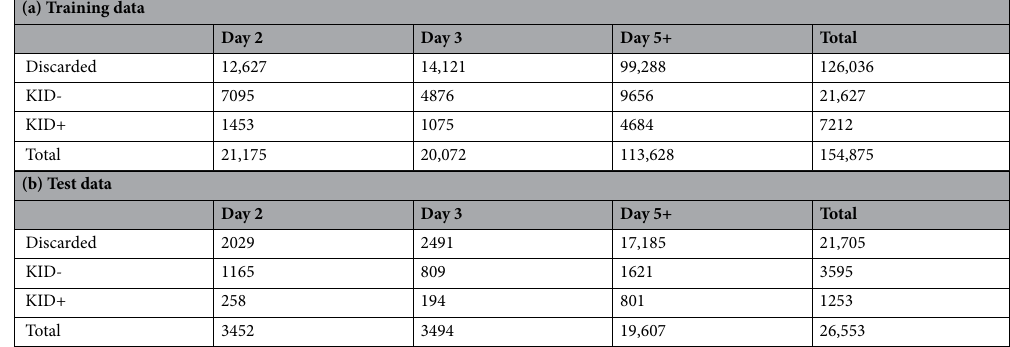
Table 1. Datasets for training and testing the